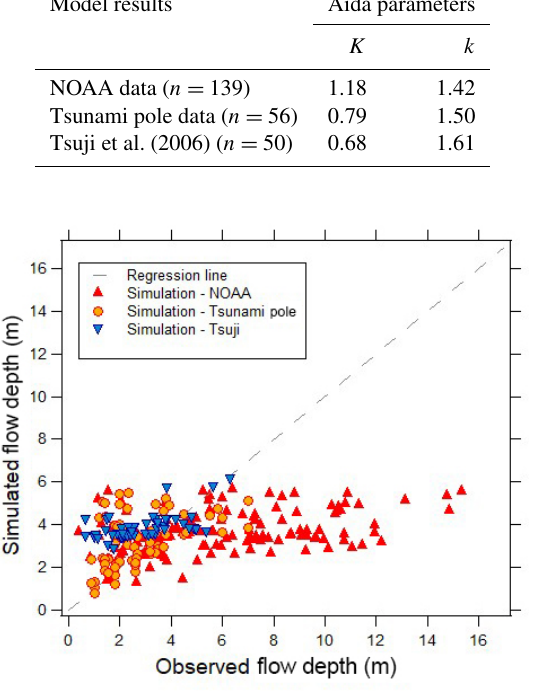
Figure 8. Comparisons between measured tsunami wave heights and simulation